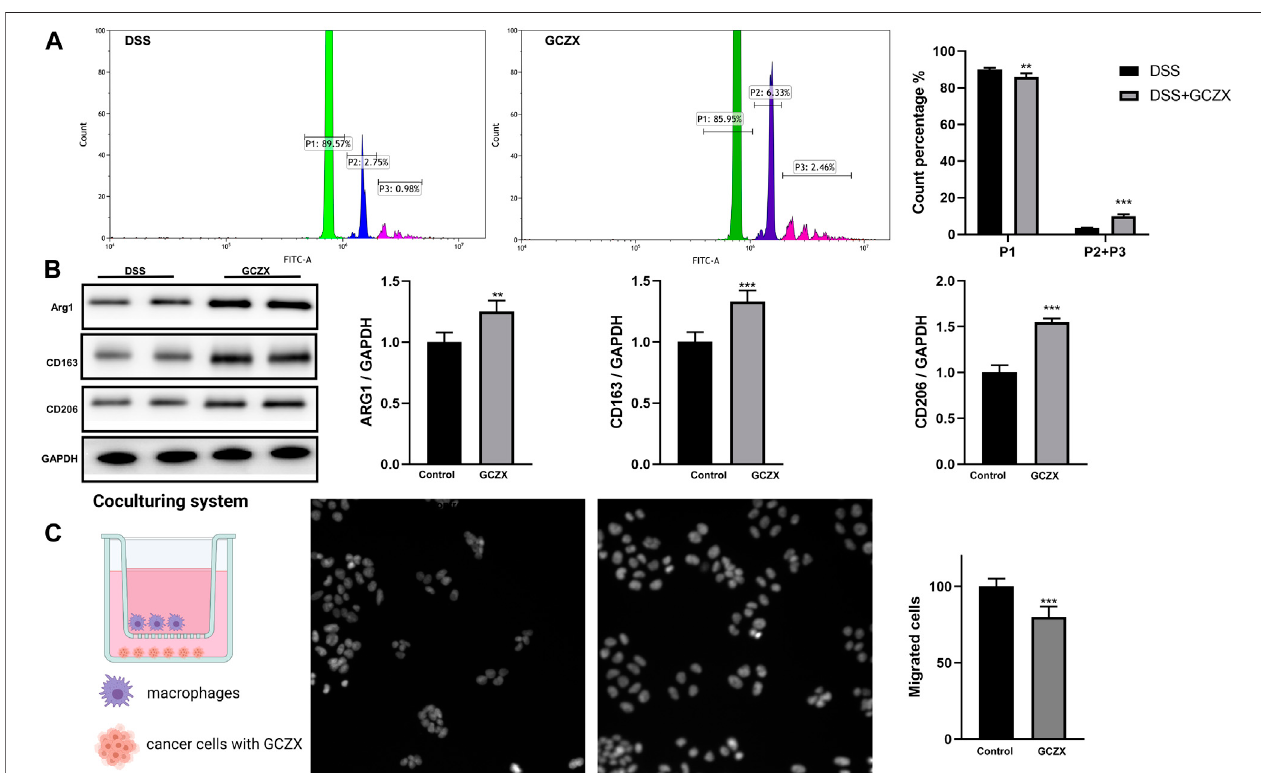
FIGURE 9 | The reciprocal interaction between epithelial cells and immune cells Bar charts (n (cid:1) 5) illustrating the phagocytic capacity of macrophages, green represents one microparticle engulfment (P1), blue represents two microparticles (P2), red represents more than two microparticles (P3) (A) ; Western blotting showing theproteinabundanceofM2macrophagemarkers (B) ;TranswellassayshowingthemigrationofmacrophagesincubatedwithGCZX-pretreatedNCM460cells(C).* p < 0.05, ** p < 0.01, and *** p < 0.001 indicates a statistically signi fi cant difference from saline group; # indicate statistically signi fi cant difference from UC